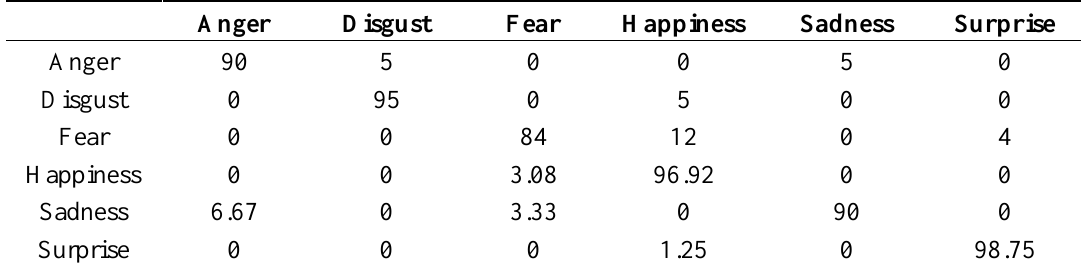
Table 2. Confusion matrix for facial expression recognition in percentages, using multi-class AdaBoost with 75 feature